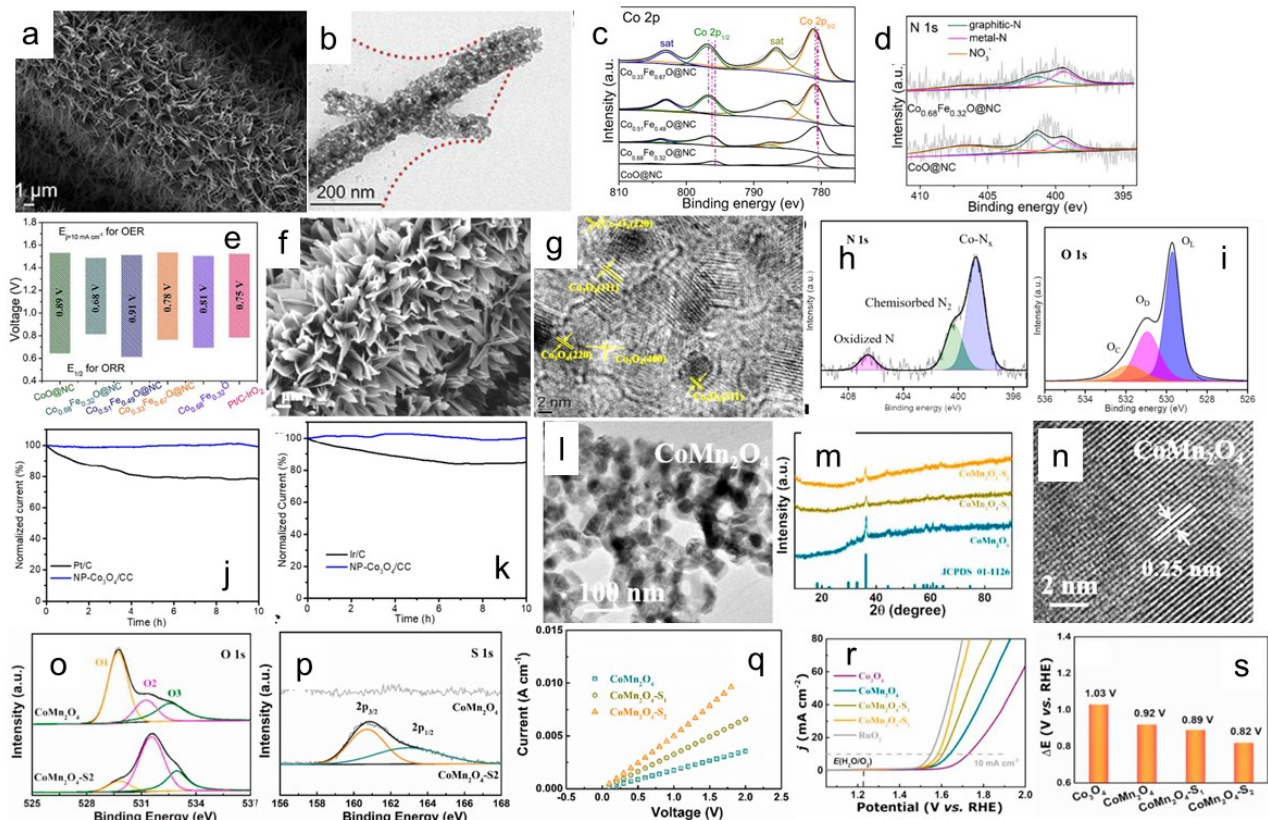
Figure 7. Characterization and electrochemical performance of typical oxide ‐ based catalysts. ( a , b ) SEM and TEM images of Co 0.68 Fe 0.32 O@NC. ( c , d ) High ‐ resolution XPS spectra of Co 2p and N 1s of Co 0.68 Fe 0.32 O@NC. ( e ) Bar plots of voltage gap between E j=10 and E 1/2 . Reproduced from [128], copy ‐